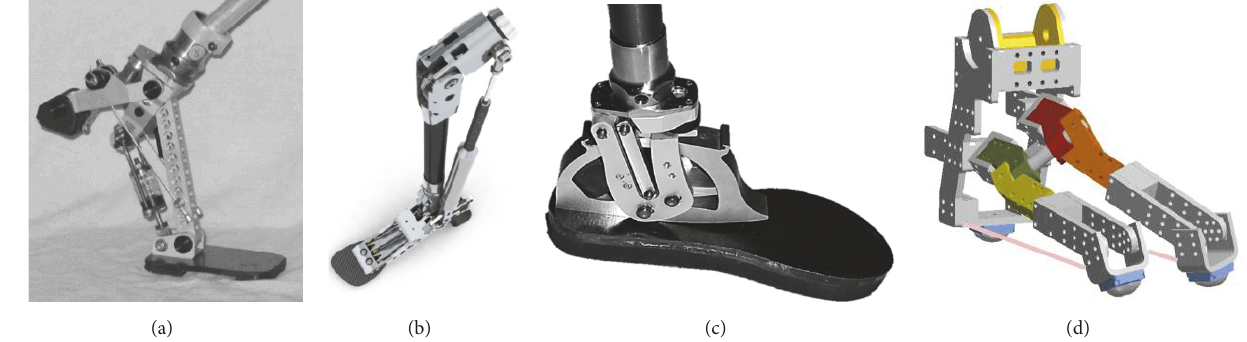
Figure 8: Passive foot prostheses. (a) The Heel Foot [8], (b) fully passive transfemoral prosthesis prototype [9], (c) prosthetic ankle-foot system [10], and (d) bipedal walking robot with oblique midfoot joint in foot [11].